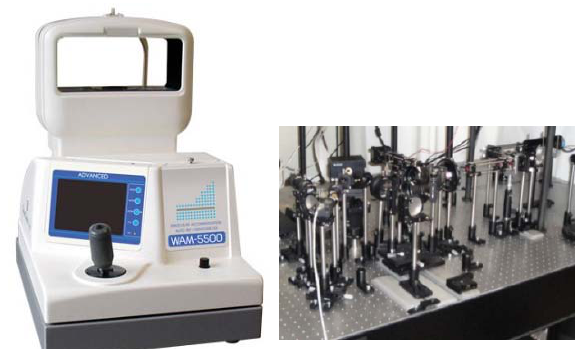
Fig. 1. Open-field utorefractor (WAM-5500, Grand Seiko Co., Ltd., Japan) on the left and Hartmann-Shack aberrometer (Thorlabs WF150-7AR) on the right.